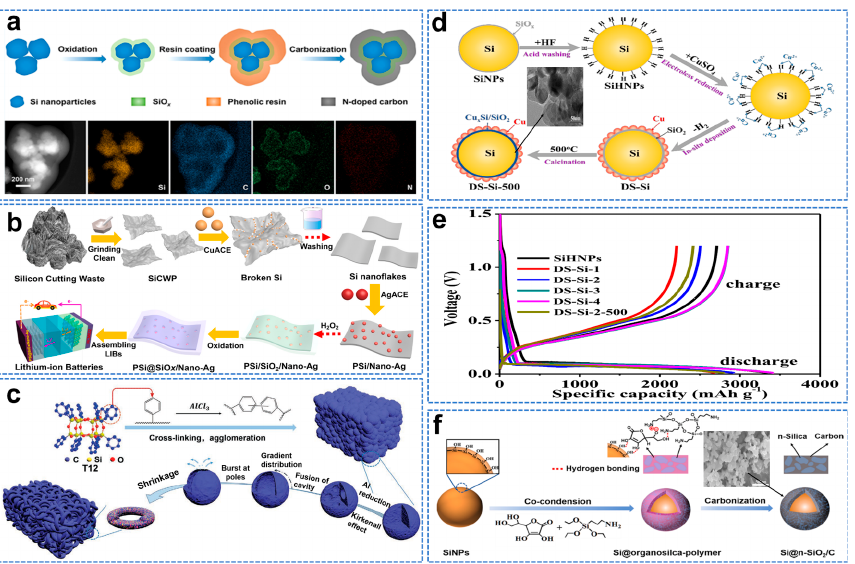
Figure 7. ( a ) Schematic illustration of the synthesis of Si@SiO x @C and EDS mappings [69]. ( b ) Illustration of the fabrication of Si@SiO x /Nano − Ag composite [70]. ( c ) The schematic illustration of synthesis of Si/SiO x /C nanorings [71]. ( d ) Schematic diagram of the synthetic process for DS − Si composites and SEM image. ( e ) First discharge/charge curves at 420 mA g − 1 [73]. ( f ) Schematic illustration of the synthesis process for Si@n − SiO 2 /C composite and SEM image [74].